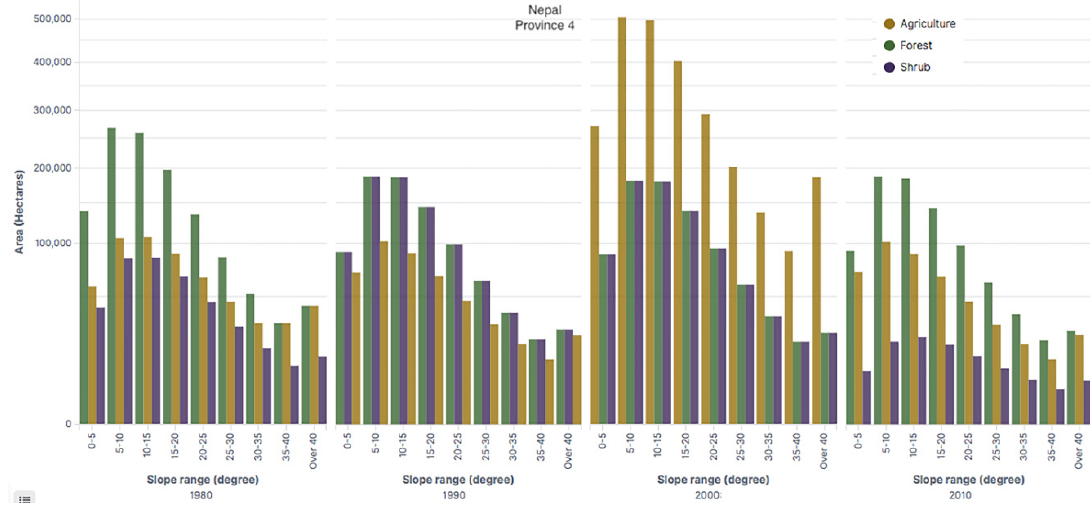
Figure 15. Province 4: forest, shrubland, and agricultural areas of Nepal by 9 elevation classes for 1980, 1990, 2000, and 2010. Table 10. Province 4: land use as a percentage of total area of forest, shrubland, and agriculture for 1980, 1990. 2000, and 2010 for entire Nepal. ((Individual land-use area for a slope class/sum of forest + shrubland + agriculture) * 100).